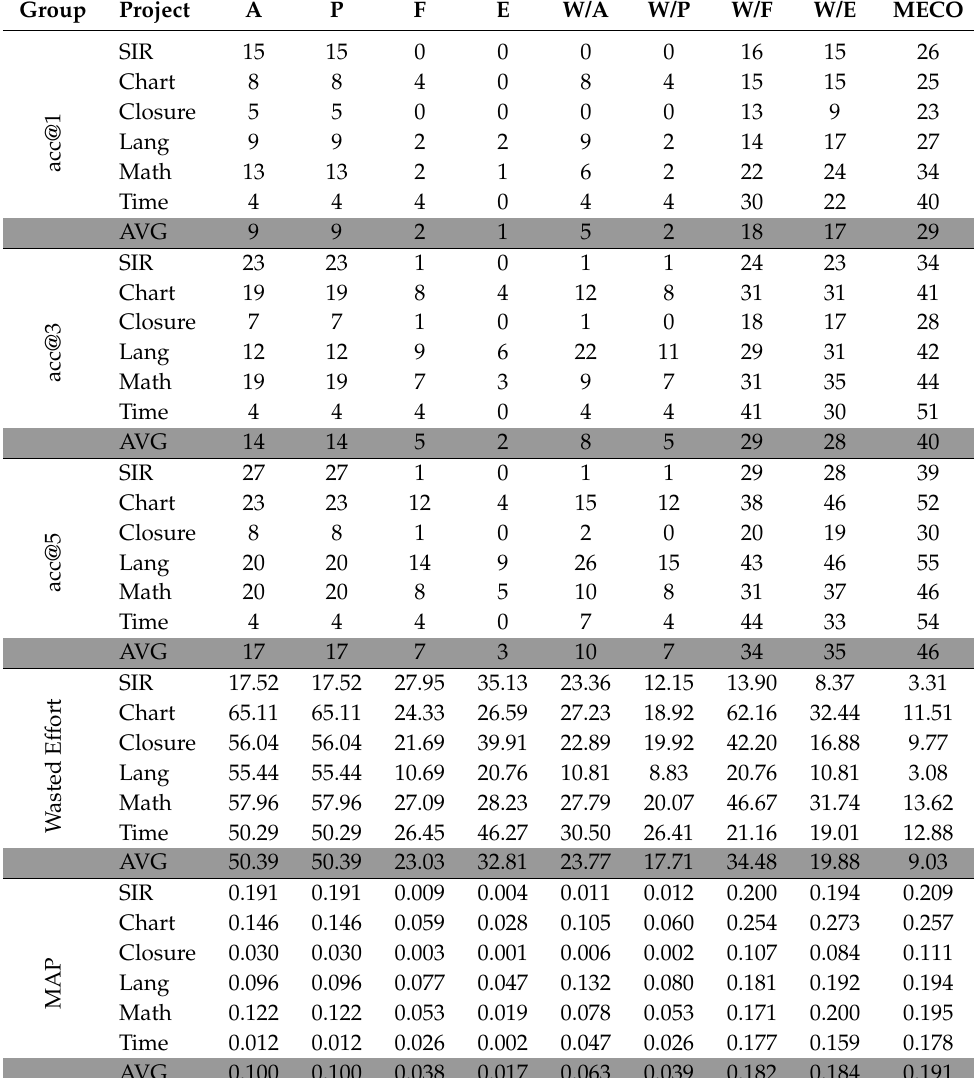
Table 4. Contribution of each metric to MECO’s performance. Assumption Proportion (P), Failed Execution Flag(F), Fault Assumption (A), Total Execution (E), MECO without A (W/A), MECO without P (W/P), MECO without F (W/F), and MECO without E